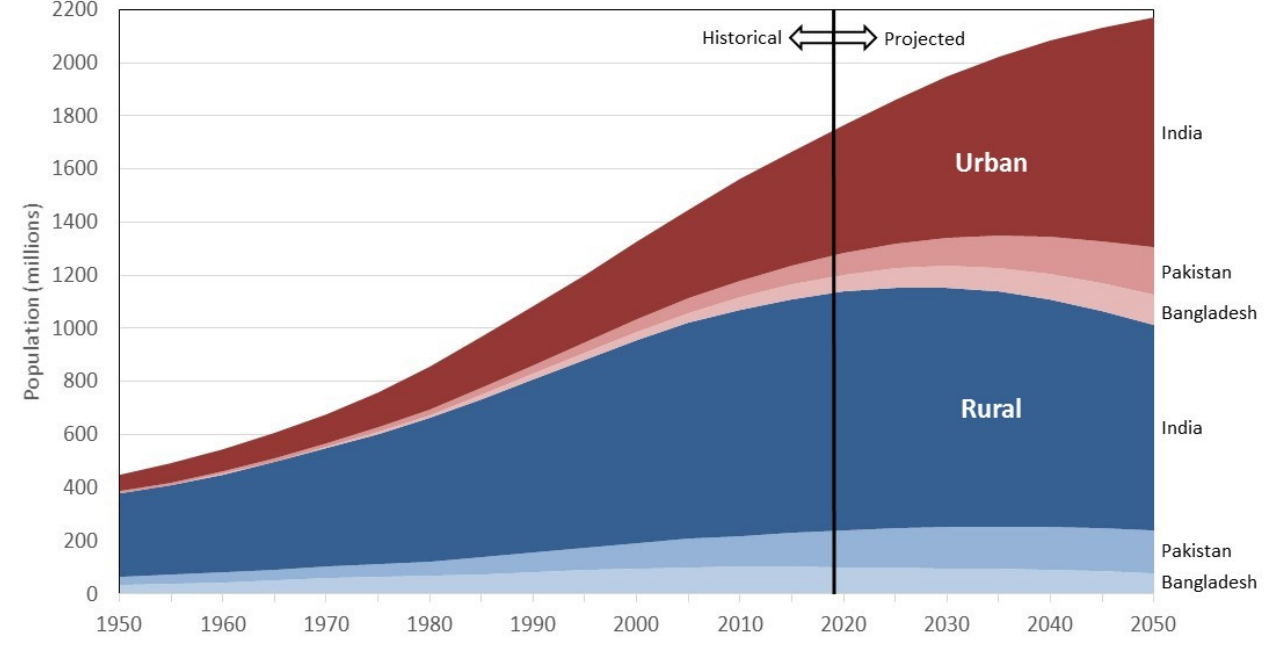
Figure 1. Urban population in South Asia is expected to double by 2050 due to rising total population as well as increasing urban proportion.